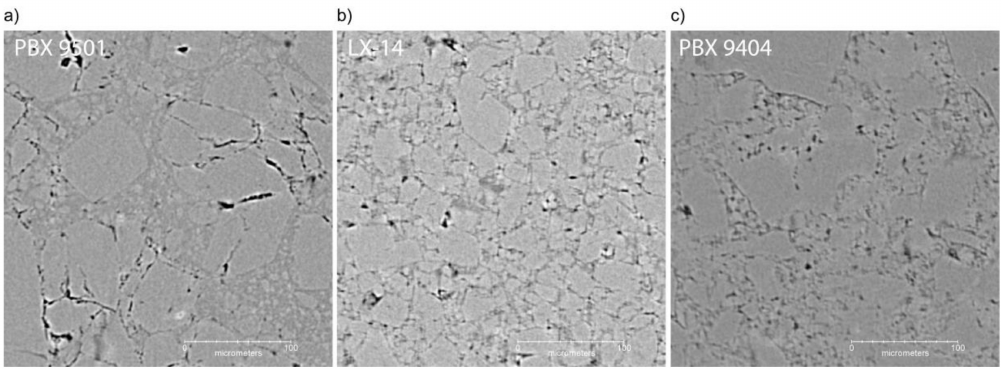
Figure 7. µ CT reconstructed slices of LX-14 ( a ), PBX 9501 ( b ), and PBX 9404 ( c )